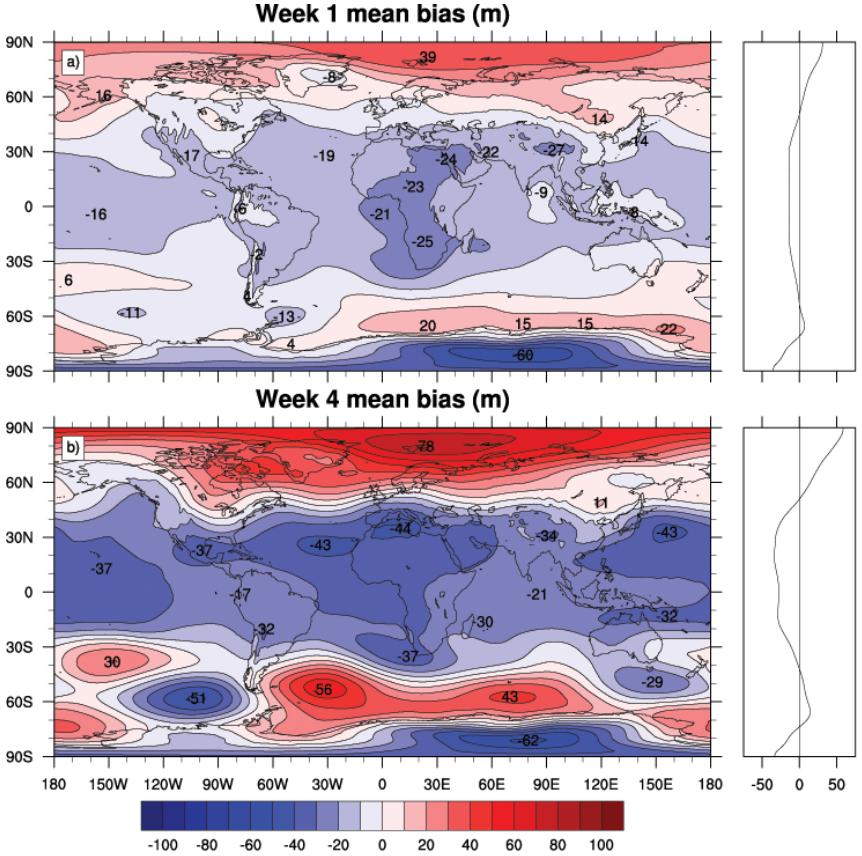
Figure 1. 500-hPa geopotential height mean bias (m) computed from reforecasts and corresponding ERA-Interim reanalyses for the 1st (a) and 4th (b) week of simulation. The zonally averaged bias is shown in side